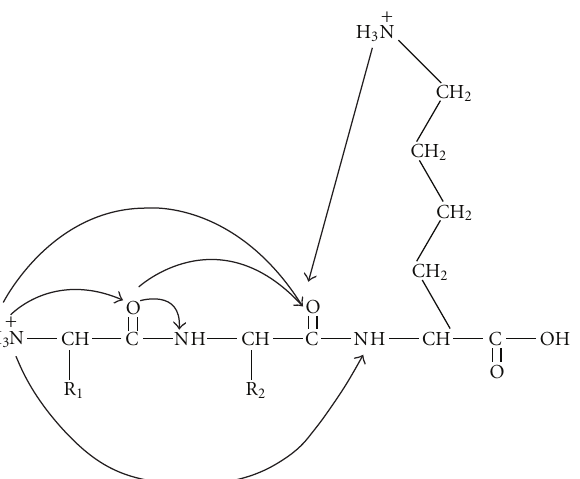
Figure 16: Mobile proton model. (Reprinted with permission from Journal of the American Society for Mass Spectrometry [156], Copyright 2010, Elsevier).